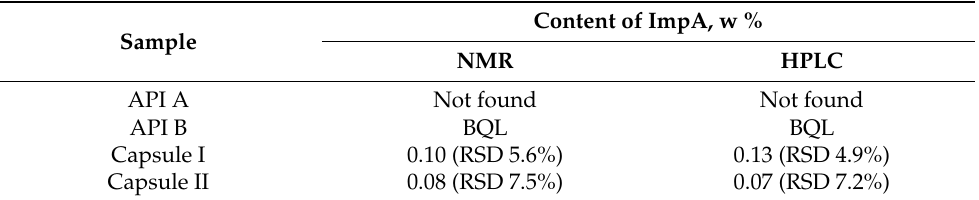
Table 5. Results of the ImpA content in GP APIs and capsules determination.